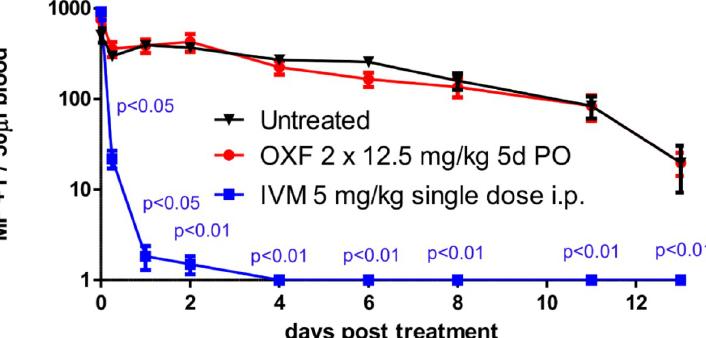
Fig 7. Oxfendazole has no in vivo efficacy against microfilariae of L . sigmodontis . Time-course of microfilariae counts in 50 μ l peripheral blood of mice injected with 100,000 microfilariae and treated the following day with oxfendazole twice daily (OXF, BID) for five days with 12.5 mg/kg per os or a single intraperitoneal dose of ivermectin (IVM, 5 mg/kg). Control animals received no treatment. Means ± SEM of 6 mice per group of one single